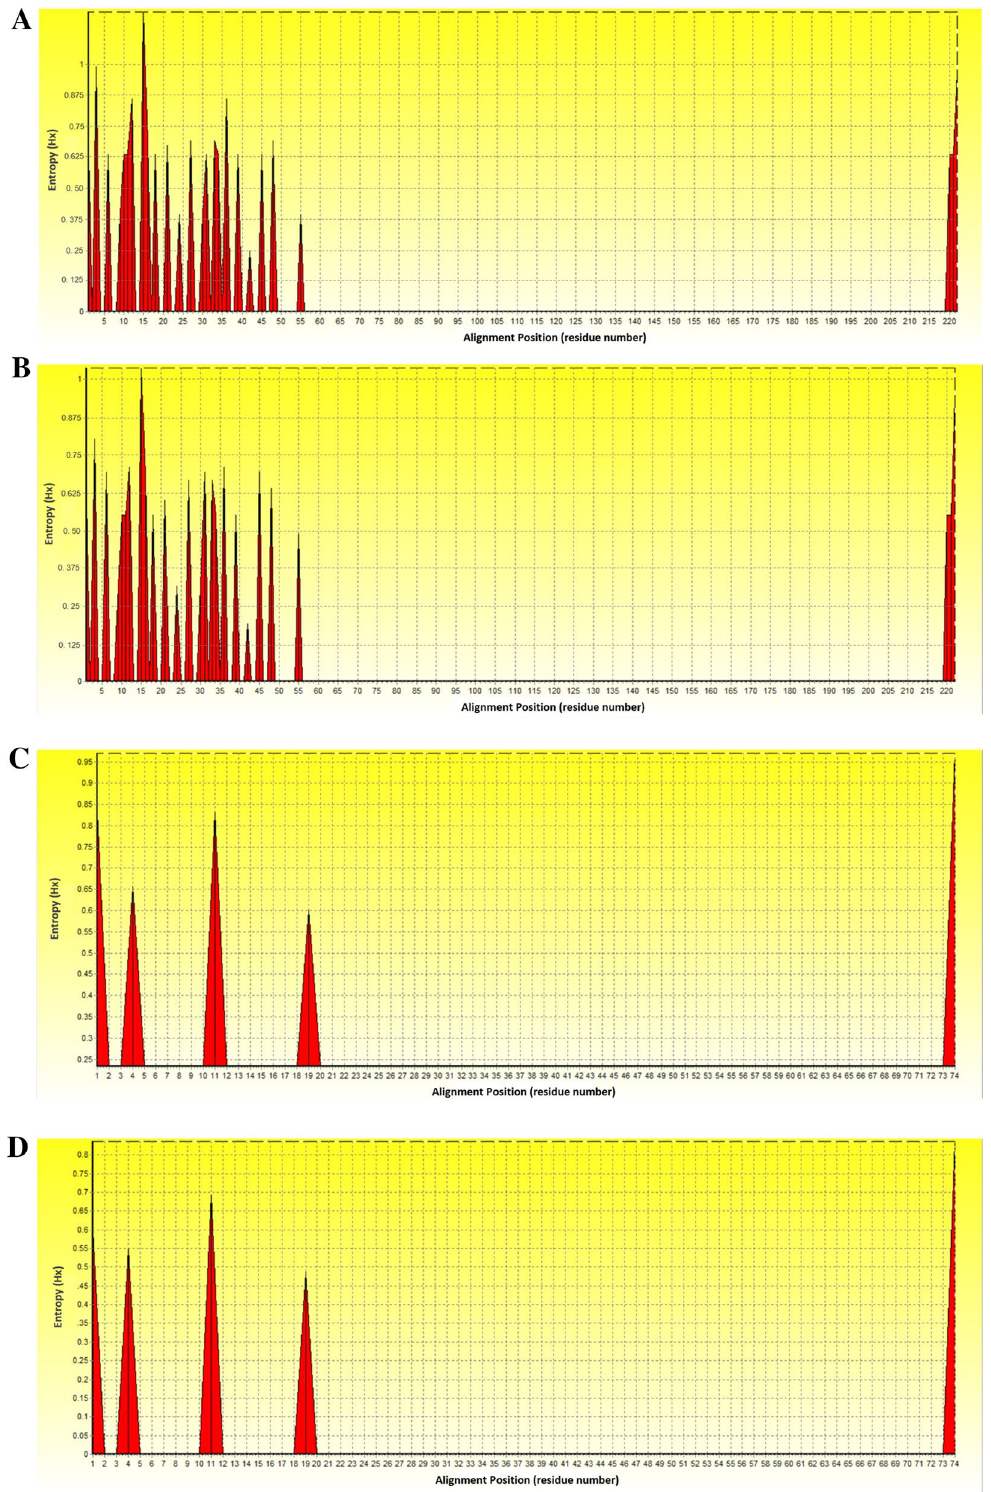
Figure 4. Nucleic and amino acid entropy plots obtained from L. sabrazesi cytb gene sequences. Entropy plot of nucleic acid sequences from Thailand ( A ) as well as Thailand and other countries ( B ). Entropy plot of amino acid sequences from Thailand ( C ) as well as Thailand and other countries ( D